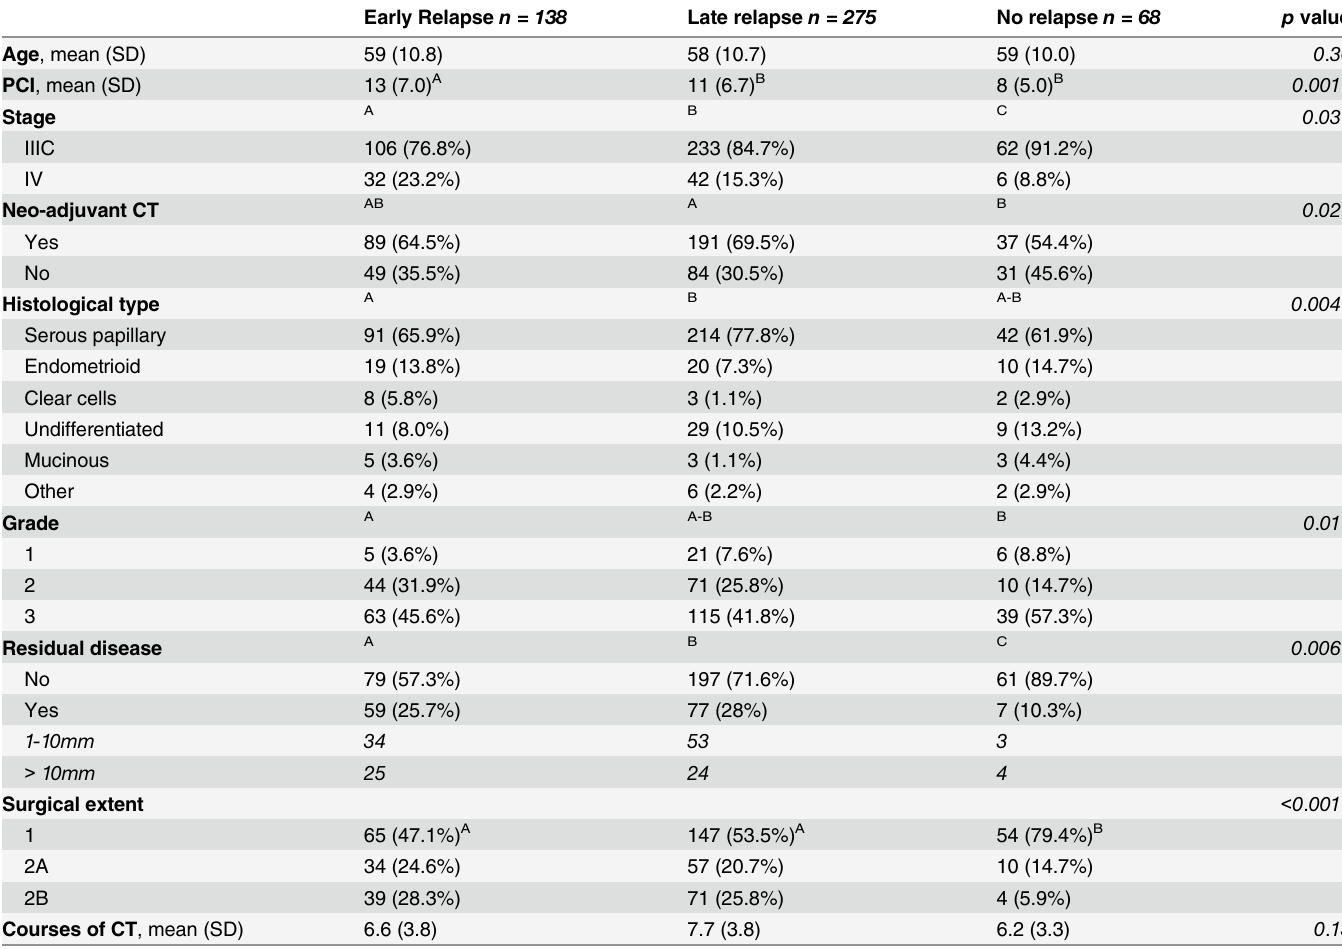
Table 1. Comparative demographics between Early Relapse, Late Relapse and No Relapse groups.